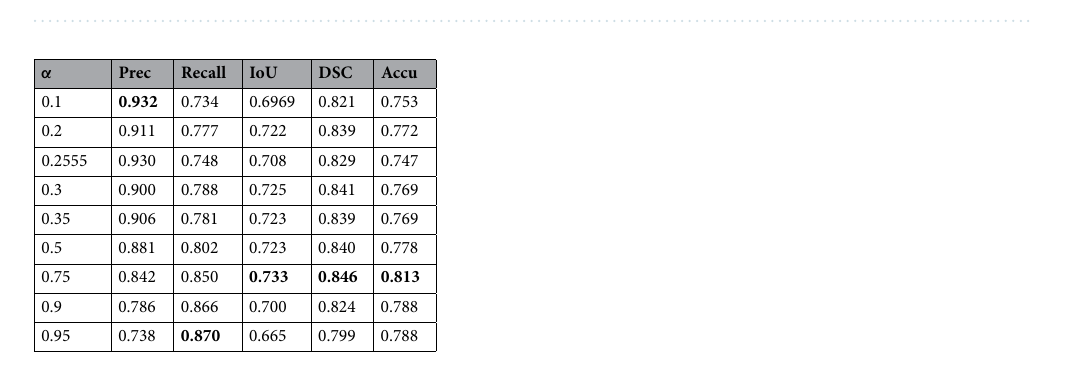
Figure 8. The focal loss values with different γ s and α s. ( a ). Focal loss without weight α . ( b ). Focal loss with different α value with fixed γ = 0 . ( c ). Focal loss with different α value with fixed γ = 2 . ( d ). Focal loss with different α value with fixed γ = 5 .